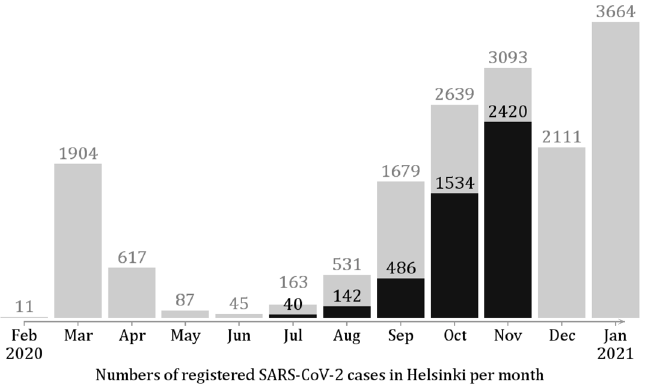
Figure 1. Monthly numbers of registered SARS-CoV-2 cases in the extended capital region of Helsinki and Uusimaa, February 2020–January 2021. The black bars shows the proportion of cases as analysed in this study, based on the SARS-CoV-2 cases in the City of Helsinki during the 5-month study period (Jul–Nov); see Table 1. The population of the HUS region is 1,650,000 and the population of Helsinki is 650,000. The average growth rate of the epidemic during the study period (Jul–Nov) was 3.0 % per day, corresponding to an effective reproduction number